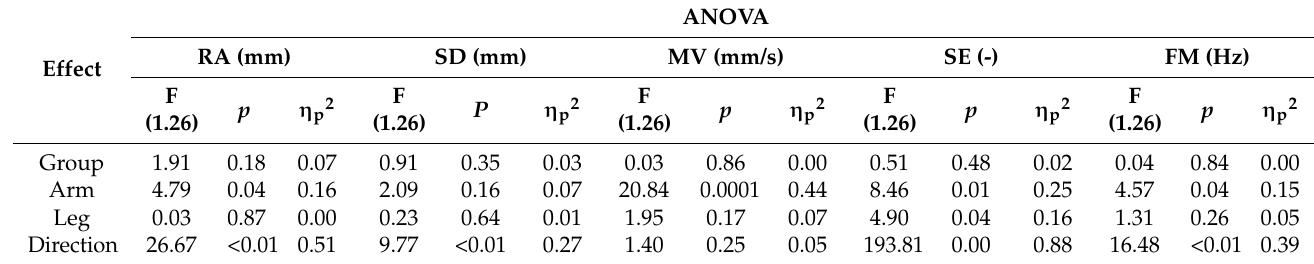
Table 3. Main effects of the analysis of variance ( η p2 , partial eta squared).